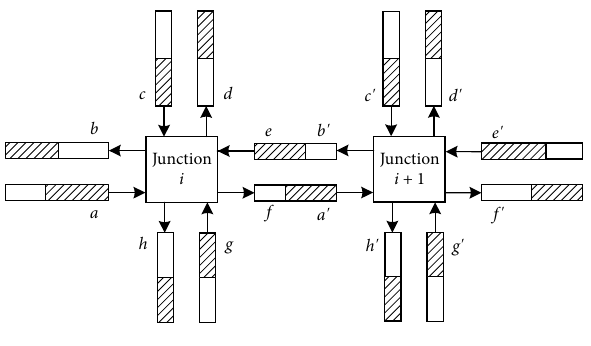
Figure 1. Two adjacent junctions